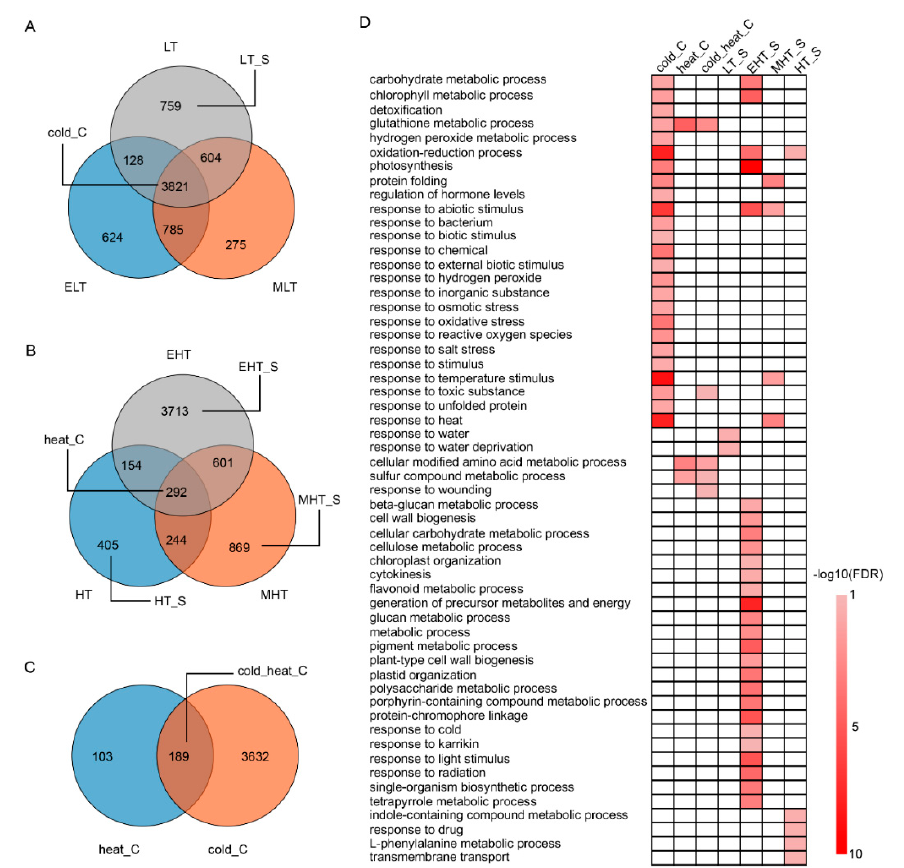
Figure 2. Comparison of differentially expressed genes (DEGs) and the corresponding gene ontology (GO) terms in response to cold and heat stress in maize seedlings. ( A ) Comparison of DEGs in response to cold stress. ( B ) Comparison of DEGs in response to heat stress. ( C ) Comparison of DEGs in response to cold and heat stress. ( D ) GO terms of the common and specific DEGs in response to cold and heat stress. C, common; S, specific. ELT, extreme low temperature, 4 °C; MLT, medium low temperature, 10 °C; LT, low temperature, 16 °C; NT, normal temperature, 25 °C; HT, high temperature, 37 °C; MHT, medium high temperature, 42 °C; and EHT, extreme high temperature, 48 °C.